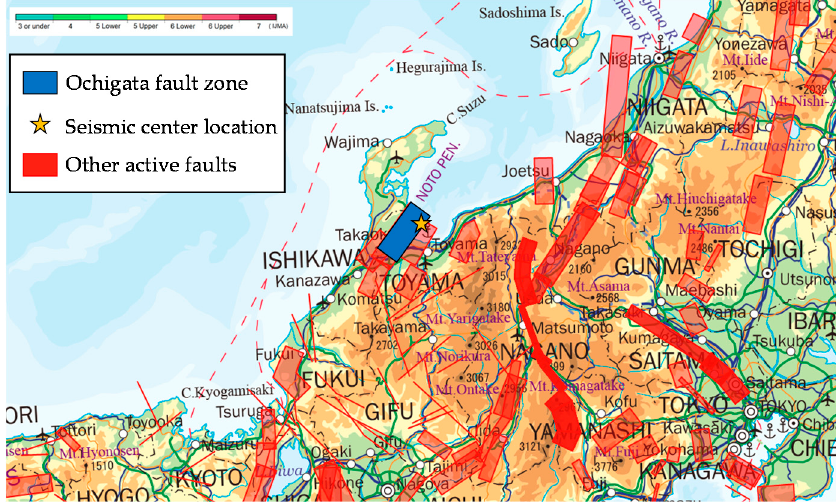
Figure 4. Ochigata fault zone and seismic center position. Int. J. Environ. Res. Public Health 2018 , 15 , x